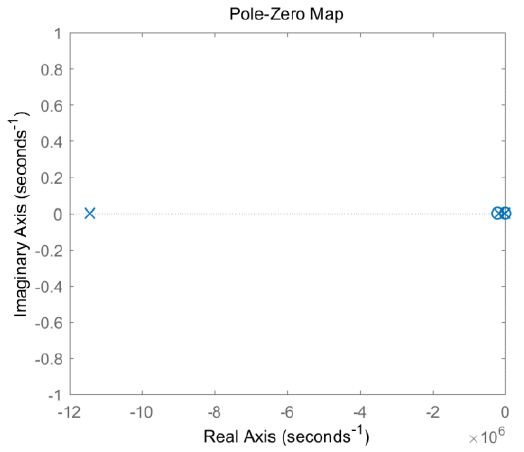
Figure 10. Zero-pole diagram of double-damped circuit model 3.